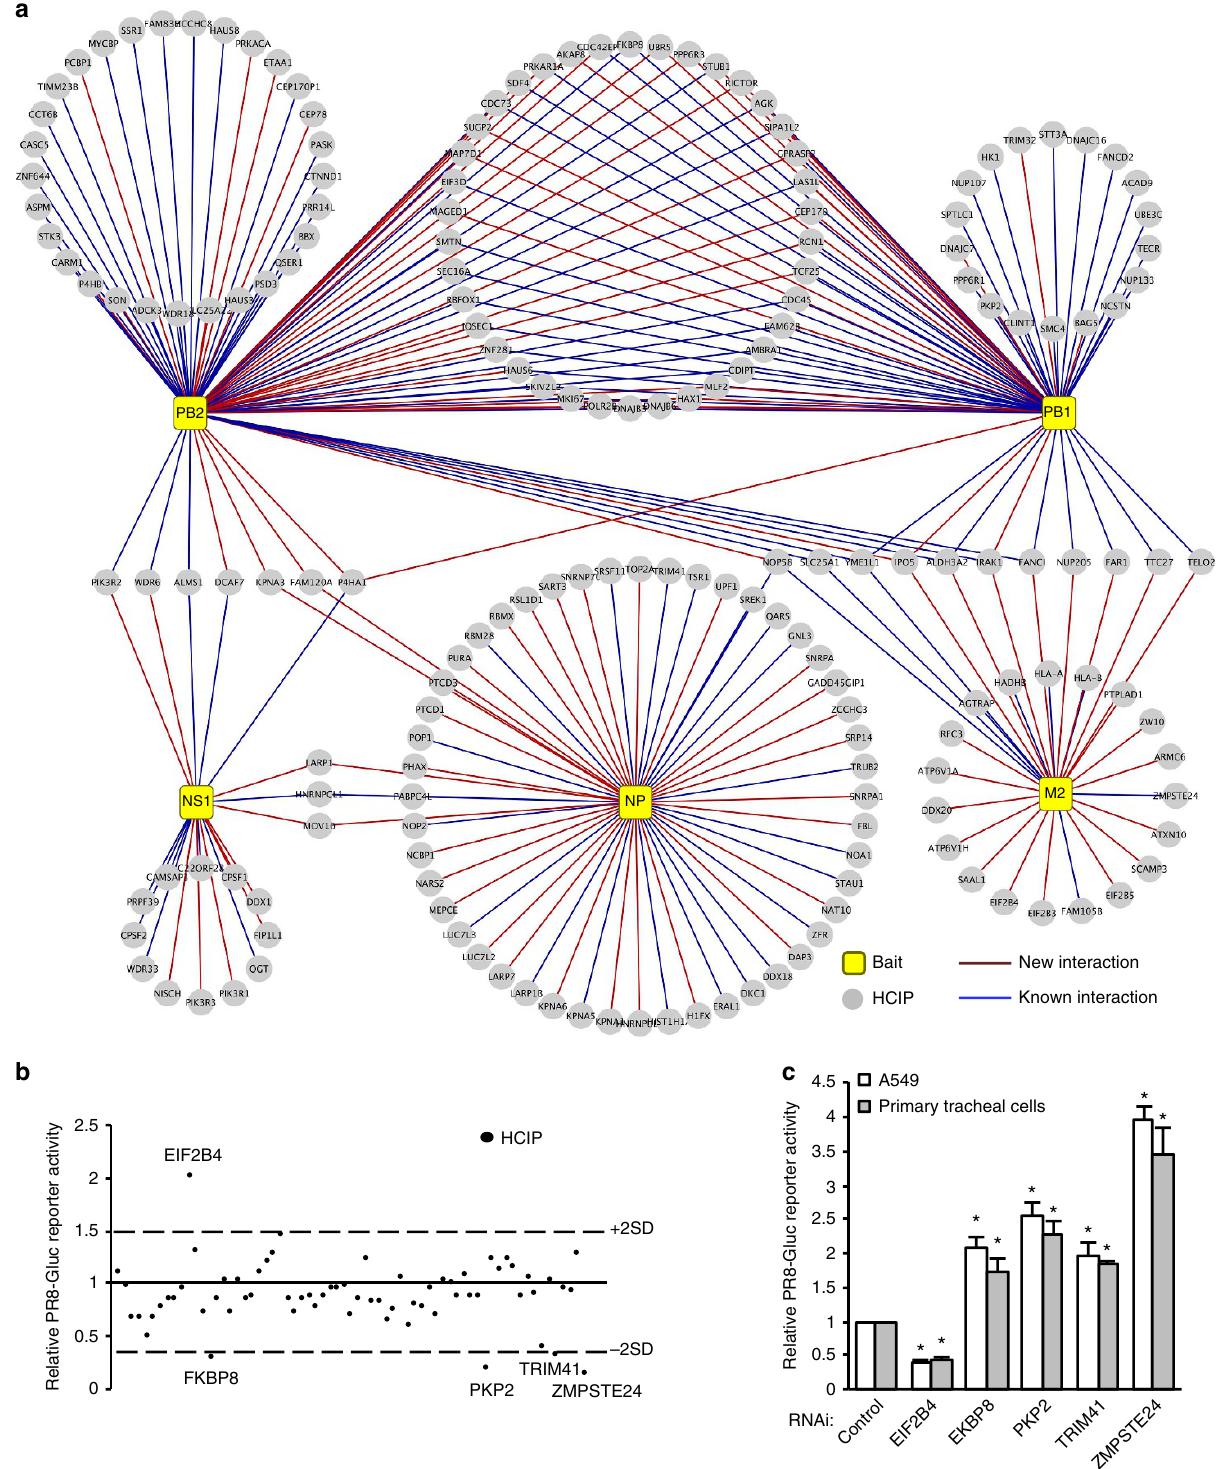
Figure 2 | Identifying HCIPs that regulate IAV infection by screening the core interactome. ( a ) Map of the core IAV–host protein interactome that comprises HCIPs associated with multiple IAVstrains in Fig. 1b. Legends are indicated. ( b ) PR8-Gluc reporter screening assay in HEK293 cells. At 24h after transfection with HCIPs, the cells were infected with 0.1 MOI of PR8-Gluc. After 16h, IAV infection activity was determined by luciferase activity. The screenings were biologically repeated two times. The dash lines indicate ± 2X s.d. of the whole screening data set. The HCIPs with 4 2 (cid:2) s.d. or o (cid:3) 2 (cid:2) s.d. are labelled. ( c ) A549 and primary human tracheal epithelial cells were transfected with control siRNA or the indicated siRNA duplexes. After 48h, the cells were infected with 0.1 MOI of PR8-Gluc for 16h. The relative luciferase activity was examined. Data represent means ± s.d. of three independent experiments. The P value was calculated (two-tailed Student’s t -test) by comparison with the corresponding siRNA control in each cell group. An asterisk indicates P o